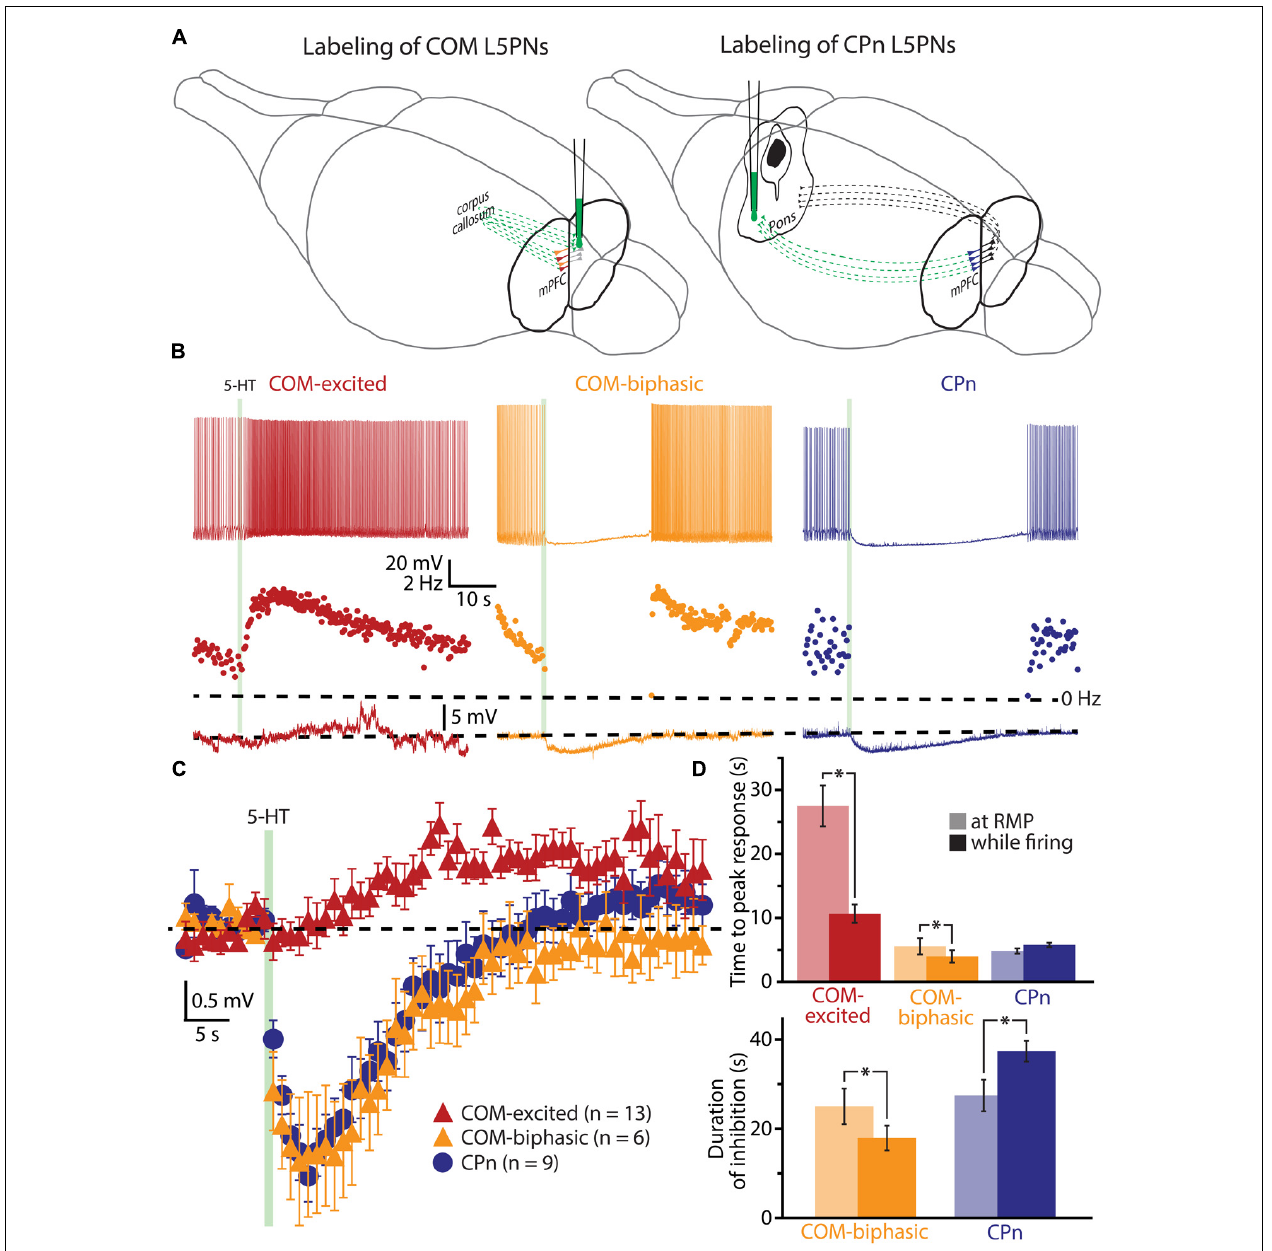
FIGURE 1 | Serotonergic excitation of COM L5PNs is more pronounced when 5-HT is paired with excitatory drive. (A) Fluorescent Retrobeads were injected unilaterally into either the contralateral prelimbic cortex (to label COM L5PNs) or into the ipsilateral pons (to label CPn L5PNs). Dashed green lines represent the axons of cortical projection neurons conveying Retrobeads to the somata of pyramidal neurons in the mPFC. (B) Responses of labeled COM-excited (red), COM-biphasic (orange), or CPn (blue) neurons to focally applied 5-HT (green bar) delivered during periods of current-induced action potential (AP) generation (top) or at resting membrane potentials (RMP, bottom). Middle plots show ISF over time. Dashed-lines indicate 0 Hz (middle)